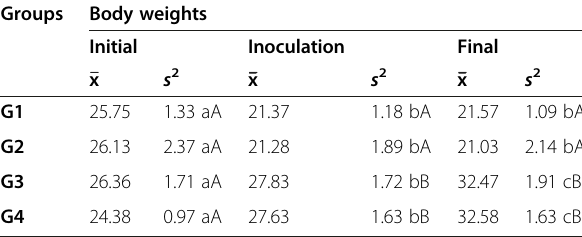
Table 1 Body weights, in grams, of BALB/c mice according to studied groups and specific moments Groups Body weights Initial Inoculation